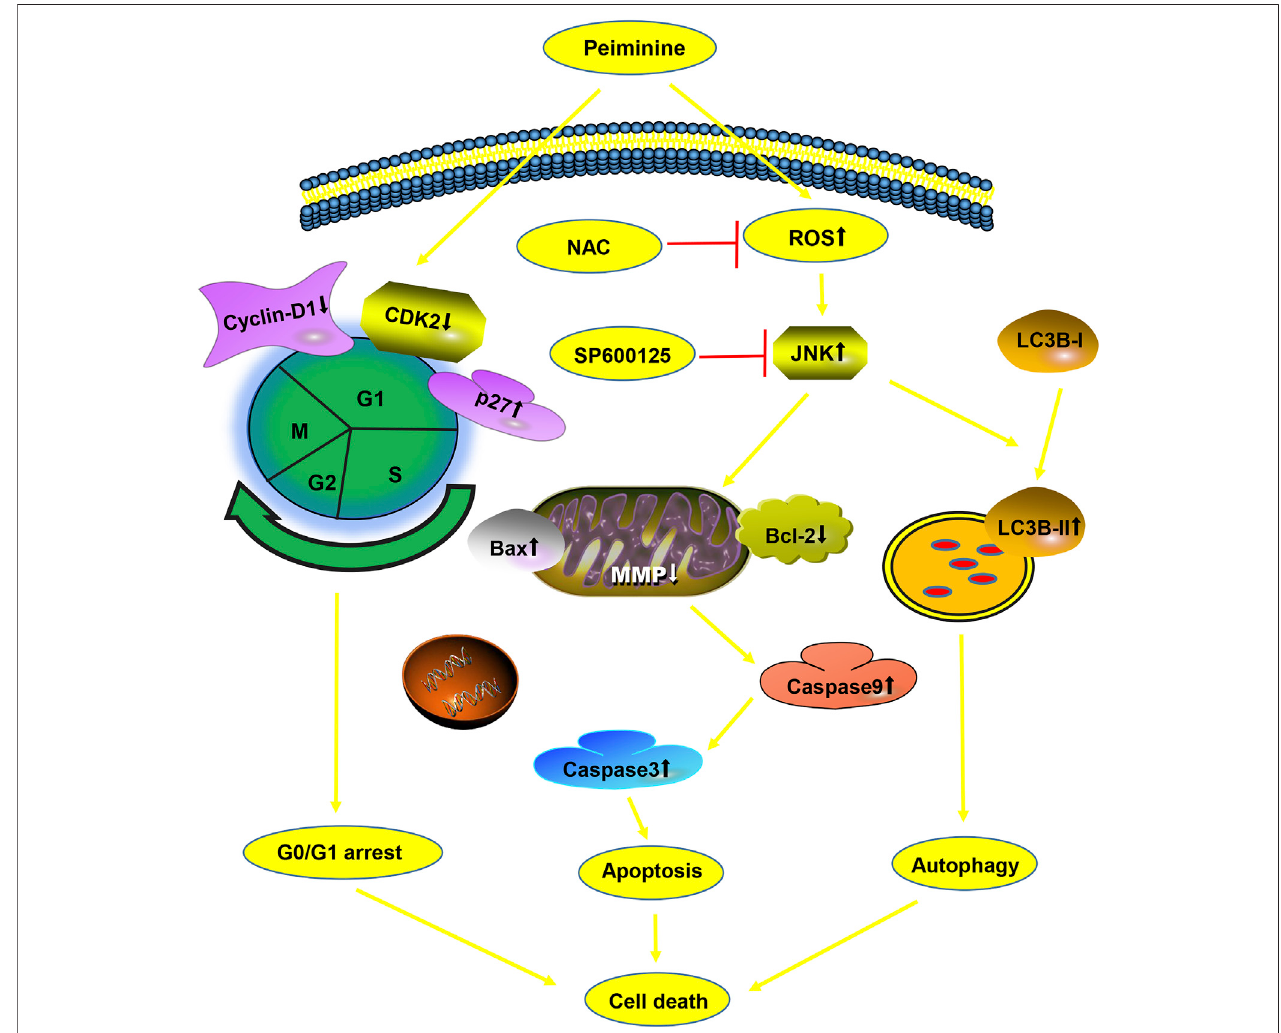
FIGURE 9 | A diagram of the effects of peiminine on osteosarcoma (OS) cells.